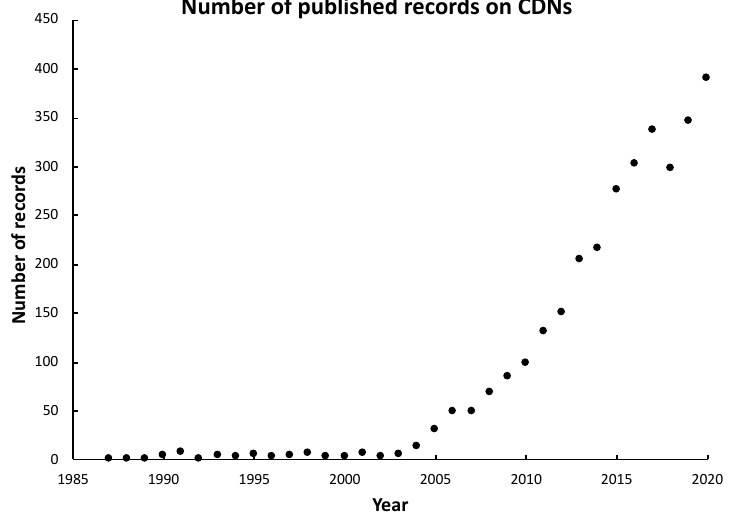
Figure 2. The number of published records on c-di-GMP and analogs retrieved (as of 20 May 2021) from the Web of Sciences with either topic or title containing one of the following terms: c-diGMP, c-di-GMP, cyclic di-GMP, cyclic diguanylic acid, c-GAMP, cGAMP, c-di-AMP, c-di-AMP, cyclic GMP-AMP, or cyclic dinucleotide, with duplicates removed.